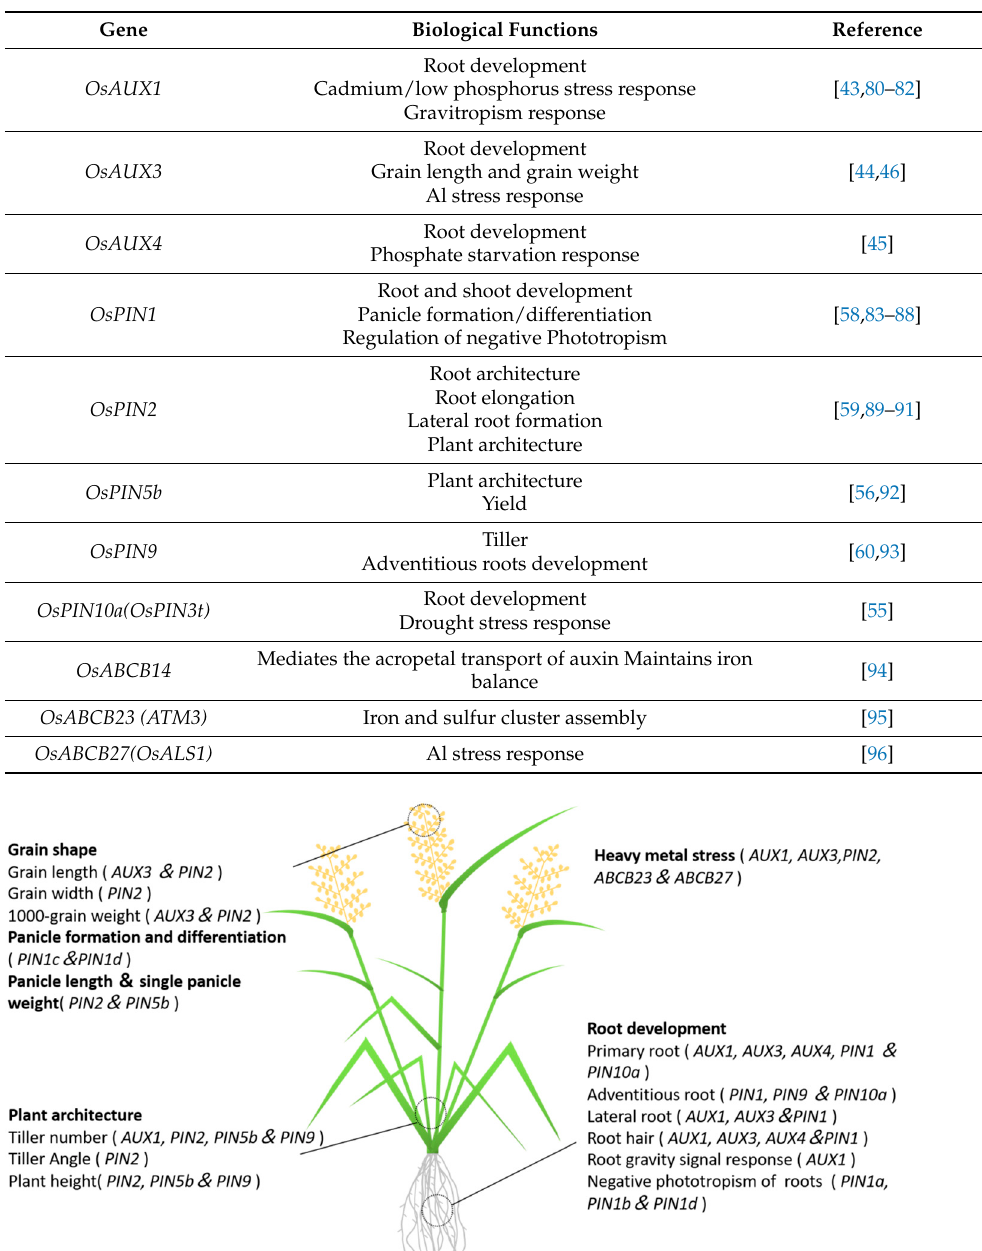
Table 1. Biological functions of auxin transporter in rice.